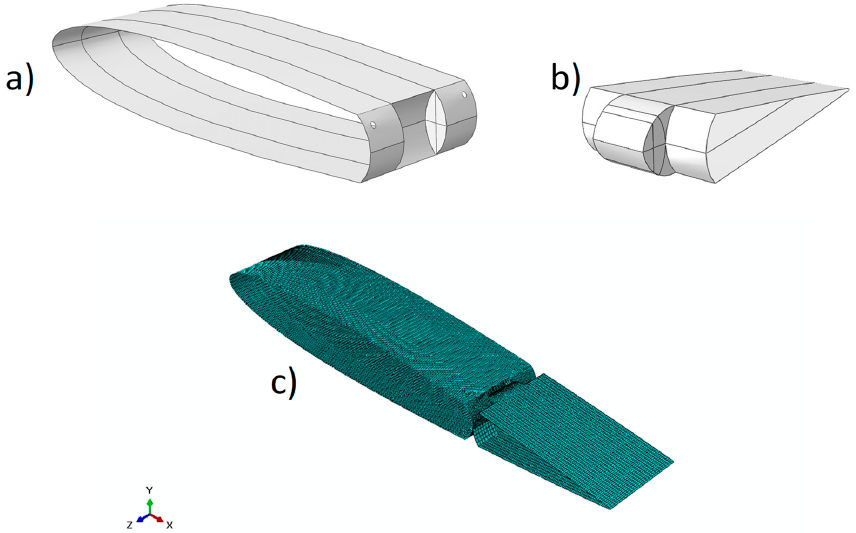
Figure 7. Case study #1 (details): ( a , b ) geometries; ( c ) FEM. Table 3. Al2024-T6 mechanical properties.